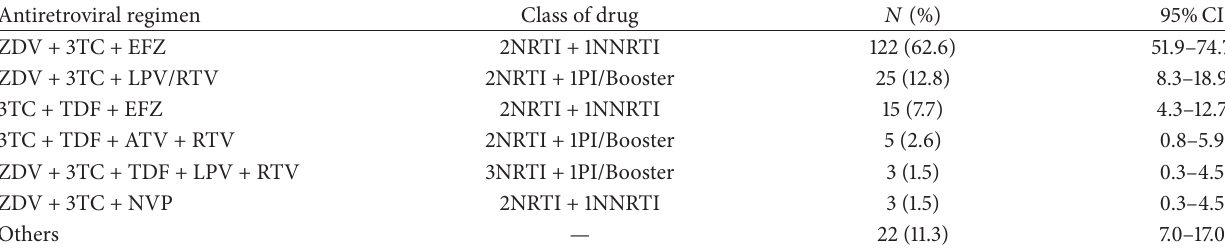
Table 2: Antiretroviral regimen in 195 HIV-infected patients.